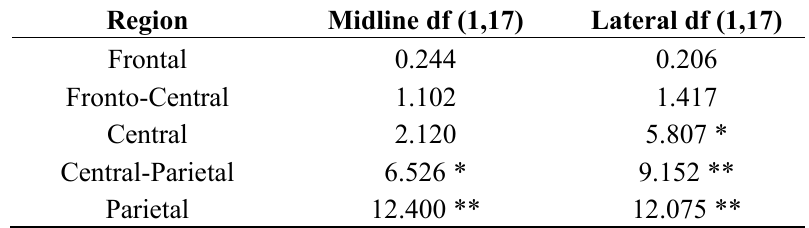
Table 7. F -values for the effect of delay, for each region, 180–280 ms from the onset of the post-delay letter.